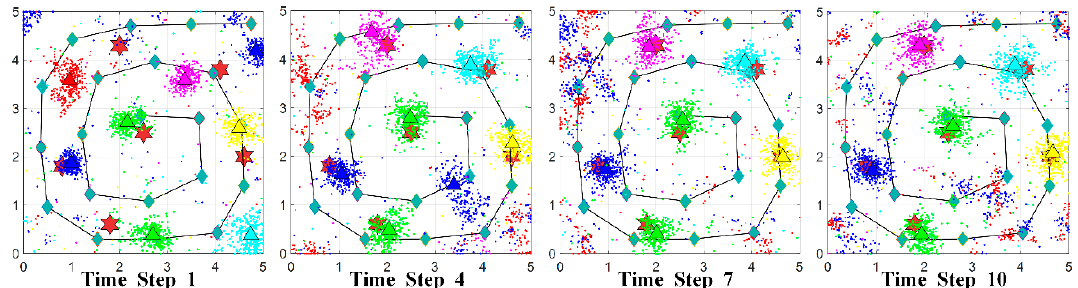
Figure 9. Progression of PSPF estimation for 6 radiation sources localization over time.